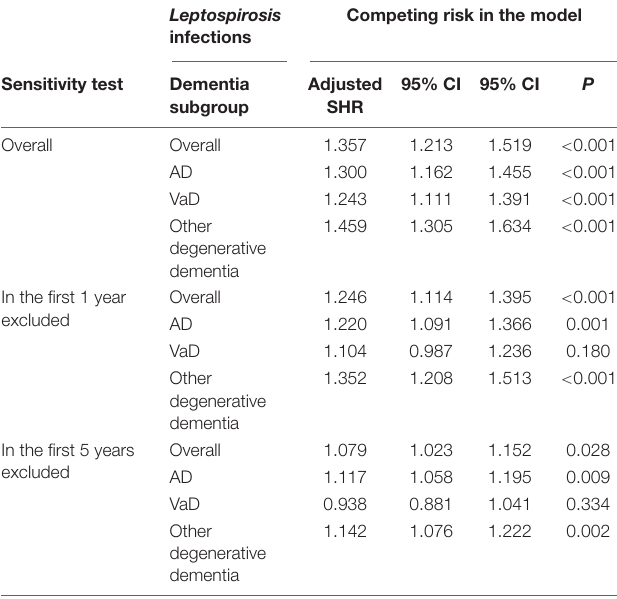
TABLE 3 | Dementia types and sensitivity analysis using Fine and Gray’s competing risk model. Leptospirosis